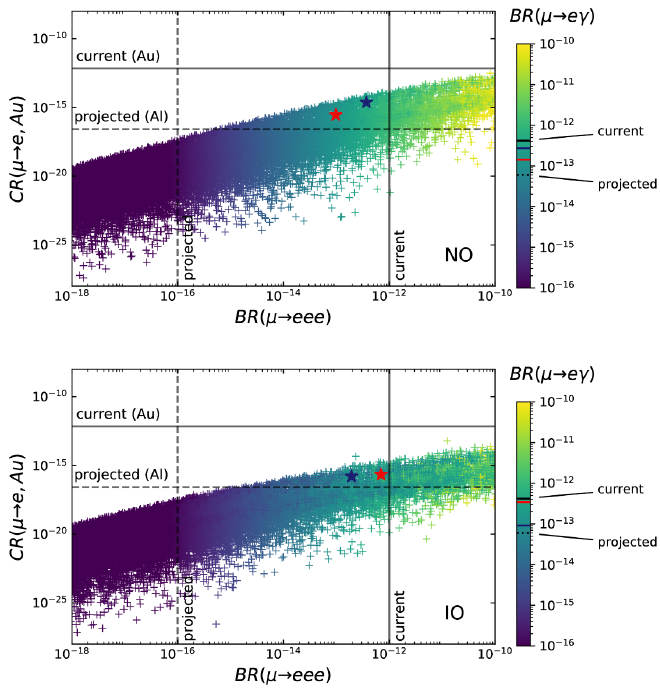
Figure 4 . Correlation between the cLFV processes µ → eee and µ → e conversion in gold nuclei for normal (upper panel) and inverted (lower panel) neutrino mass ordering. The points are colored according to the size of the branching ratio of the µ → eγ process, as shown in the color bars. The current upper bounds are indicated by the black full lines, while the future sensitivities, by the black dashed lines. The blue and red star points correspond to the benchmarks BP1 and BP2, respectively (see table 4). In the bars, the current and projected bounds for µ → eγ and the benchmark points are indicated by strips, which employ the same color convention as before.